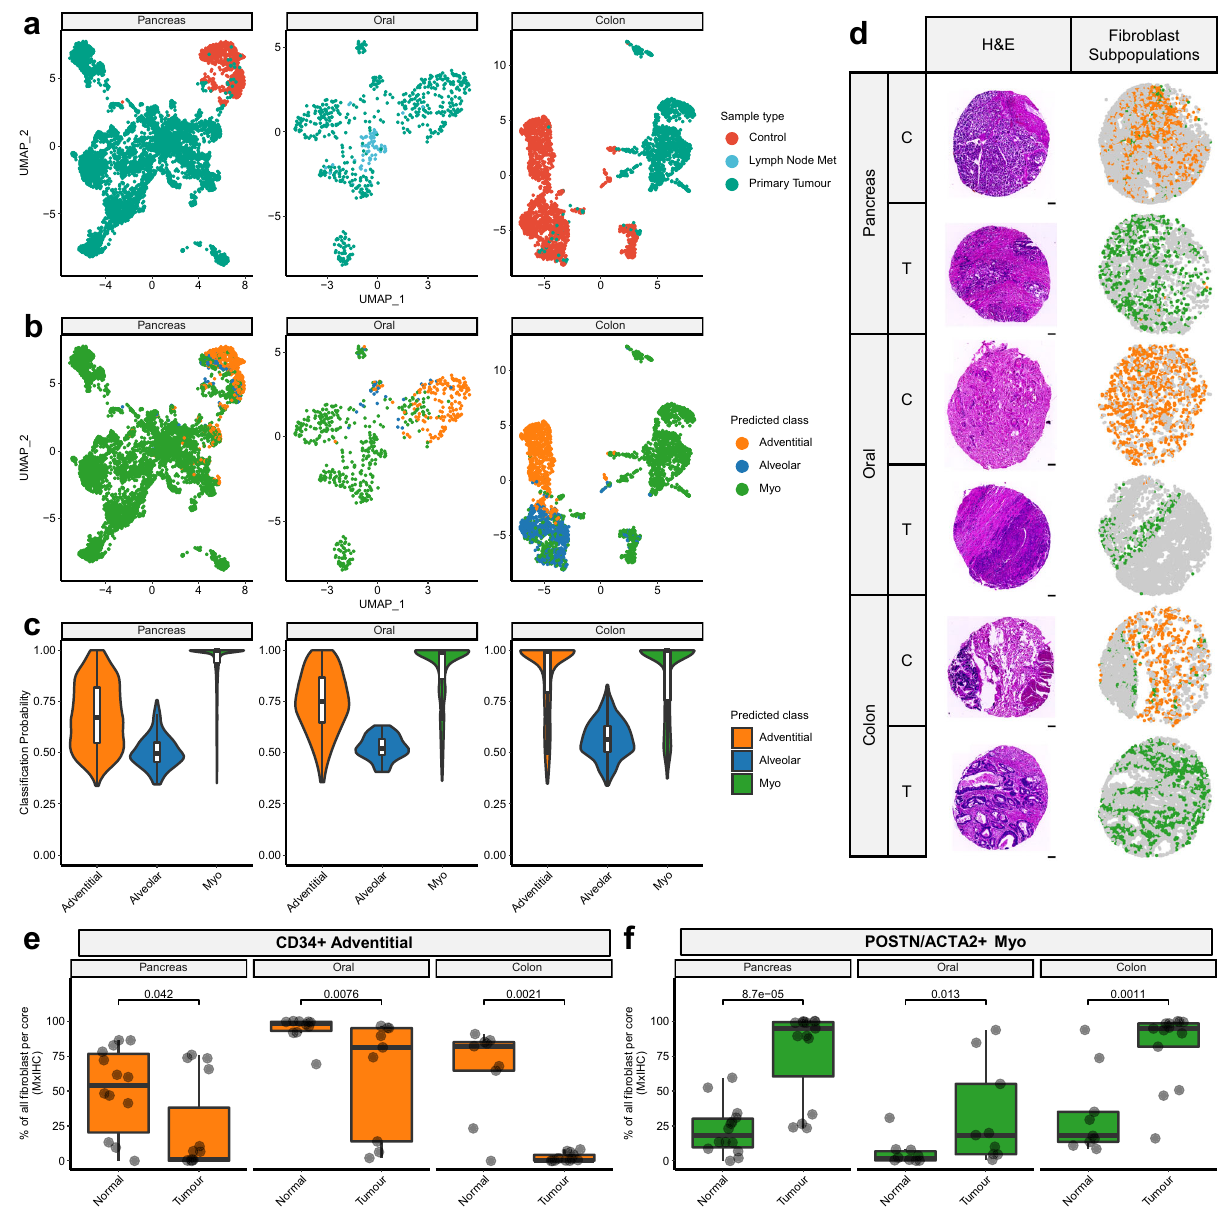
Fig. 5 | Machine learning-based classi fi cation of scRNA-seq data and mxIHC shows adventitial and myo fi broblasts are conserved across pancreatic, color- ectal and oral cancers, whereas alveolar fi broblasts are lung-speci fi c. a 2D visualisation (UMAP dimensionality reduction) of fi broblasts isolated from differ- entcancertypesandanalysedbyscRNA-seq,highlightingthesampletype. b Asper a , highlighting the fi broblast subpopulation associated with each cell as predicted by a machine learning classi fi er. c Violin plots showing the probability of the machine learning classi fi er model ’ s predictions grouped by subpopulation ( n =6875 [Pancreas], 611 [Oral] and 3297 [Colon] fi broblast transcriptomes). d Representative images from mxIHC analysis of tissue microarrays (TMAs), con- structed from pancreatic, oral and colon cancer tissue blocks (n cores analysed Control/Tumour=14/15 [Pancreas], 10/9 [Oral], 9/13 [Colon]). Showing H&E